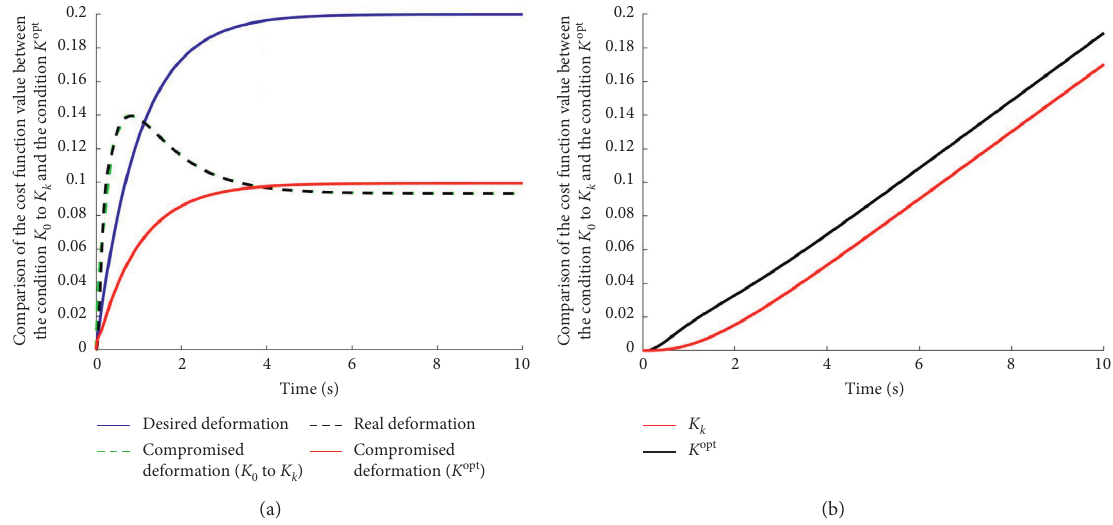
Figure 10: (a) The comparison of the object deformation information between different K ∗ values and (b) the comparison of the cost between different K ∗